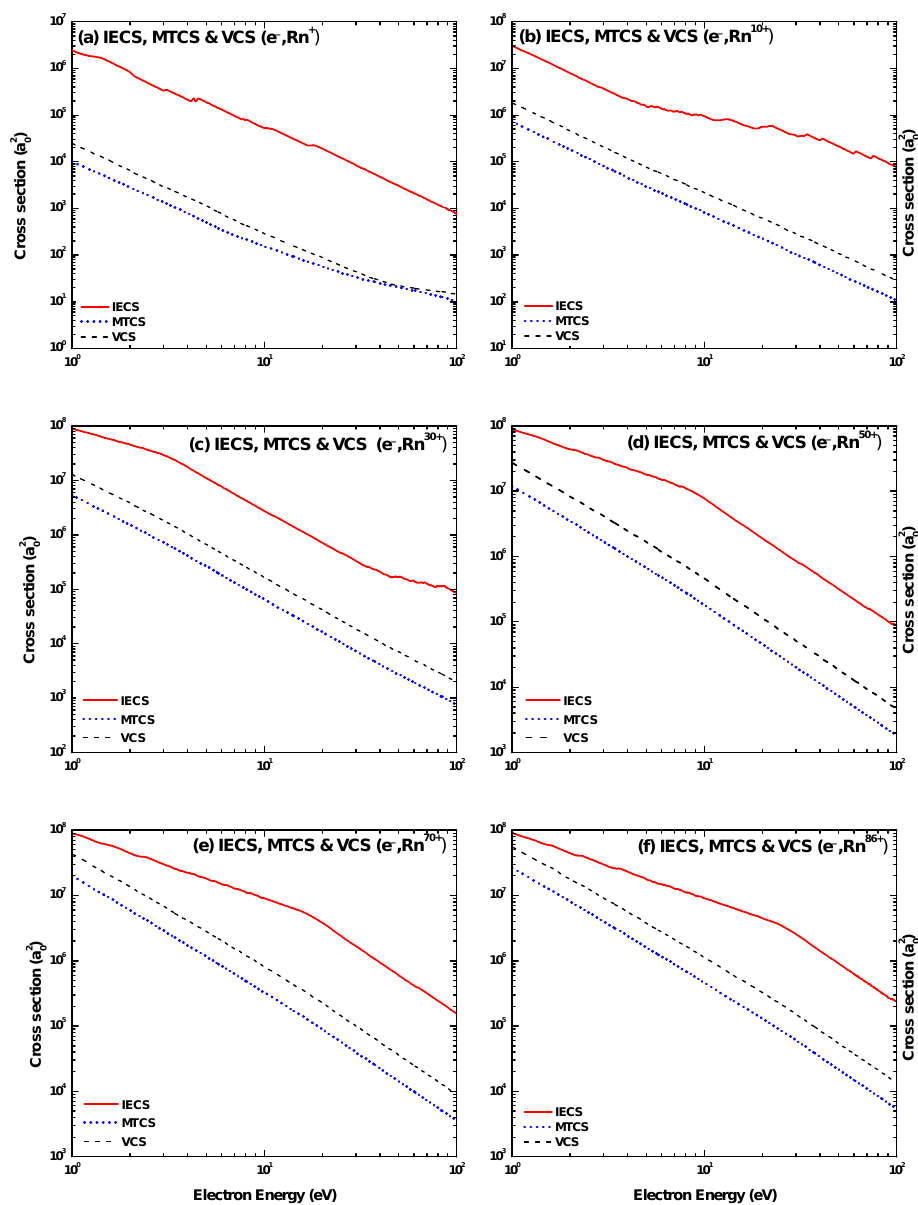
Figure 30. Energy dependence of the IECS, MTCS and VCS for the elastic scattering of electrons from ( a ) Rn + , ( b ) Rn 10 + , ( c ) Rn 30 + , ( d ) Rn 50 + , ( e ) Rn 70 + and ( f ) Rn 86 +